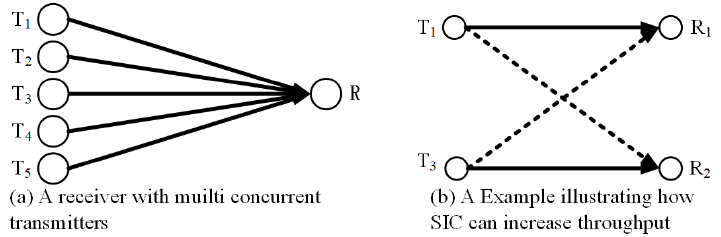
Figure 1. A wireless sensor network with a mobile charger. SIC = Successive Interference